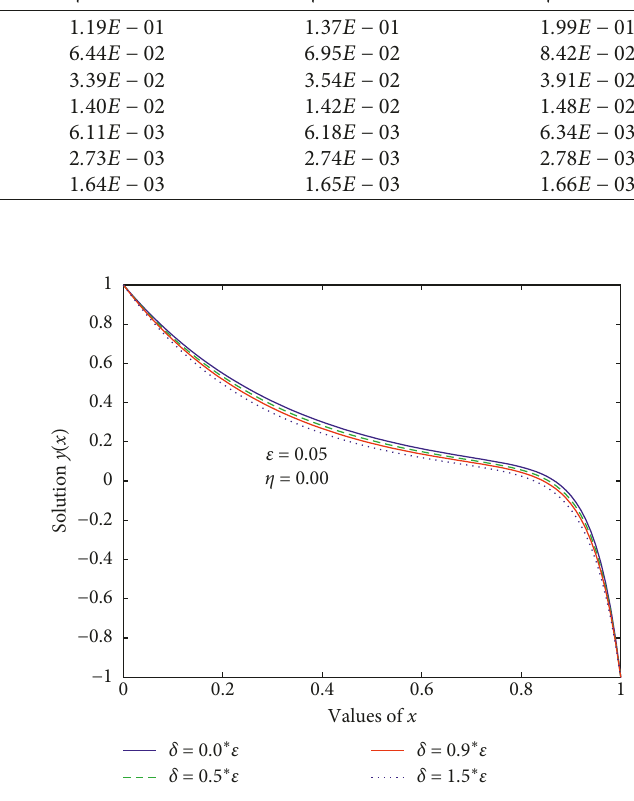
Figure 4: Approximate solution of Example 3 for different values of δ .